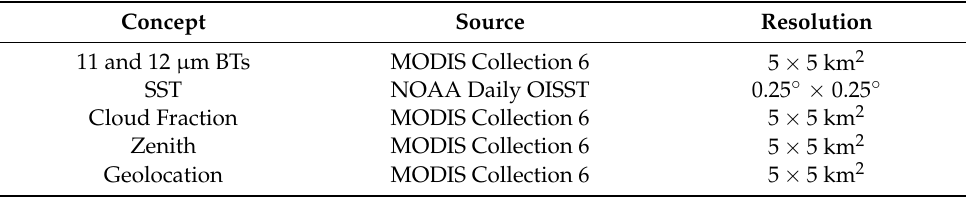
Table 2. Data used in this